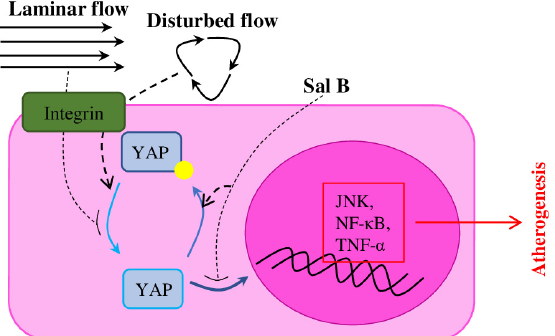
Figure 4. Haemodynamics regulates YAP/TAZ signalling in ECs. YAP/TAZ is a haemodynamics- induced mechanotransduction system. Laminar flow suppresses transactivation activity of YAP/TAZ, while disturbed flow reduces pYAP. Suppression of YAP activity with Sal B results in decreased expression of YAP/TAZ target genes (including pro-inflammatory cytokines) and retards atherosclerosis.